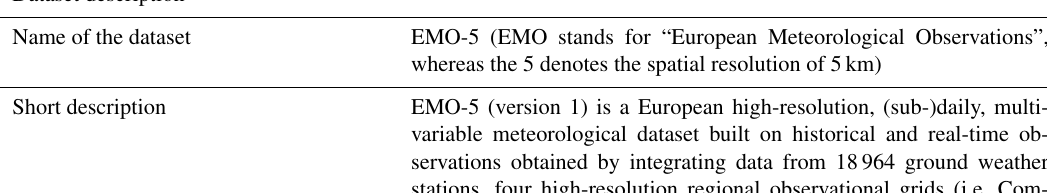
Table 7. Brief product specification of EMO-5. Dataset